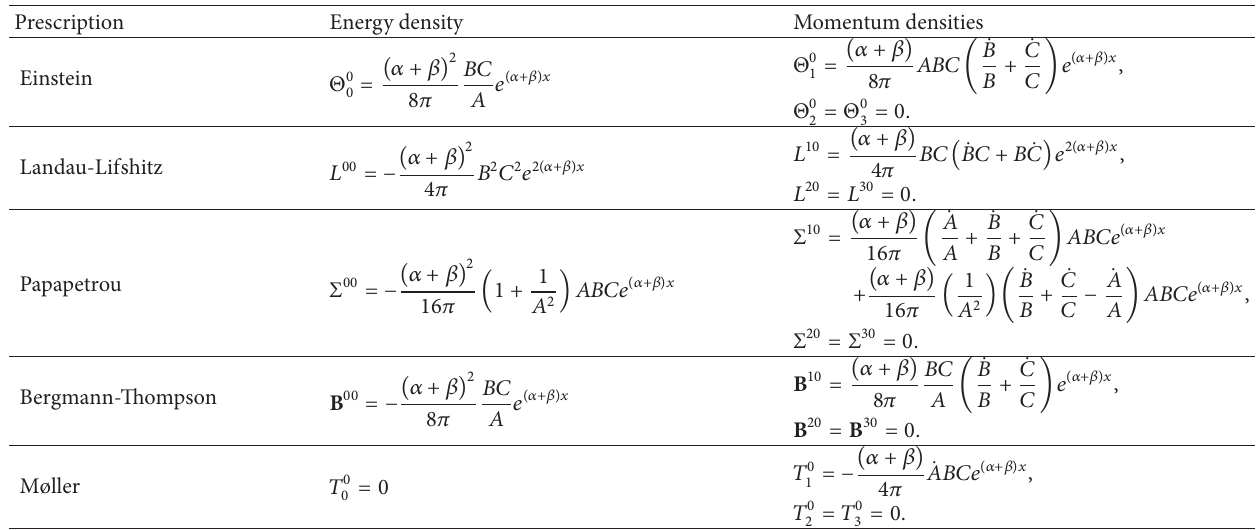
Table 2: Energy and momentum densities of diagonal Bianchi type Universes using different energy-momentum prescriptions used in the present